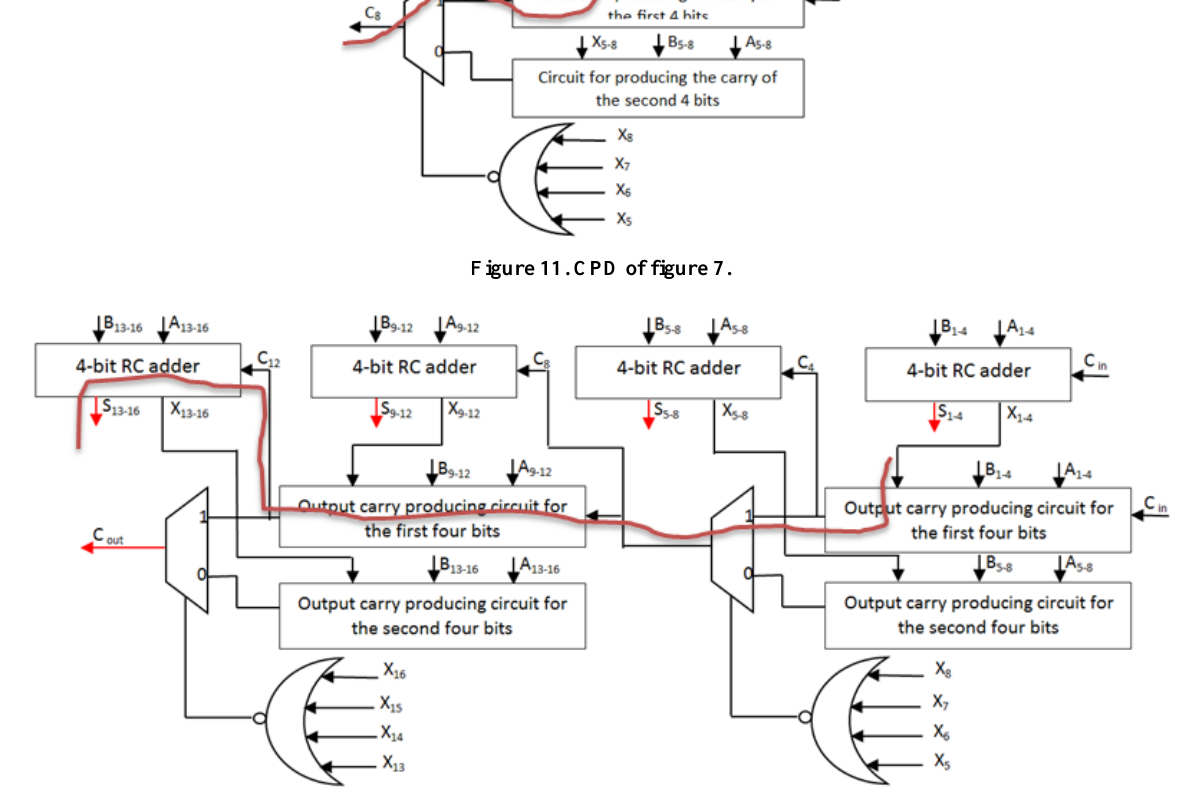
Figure 12. CPD of figure